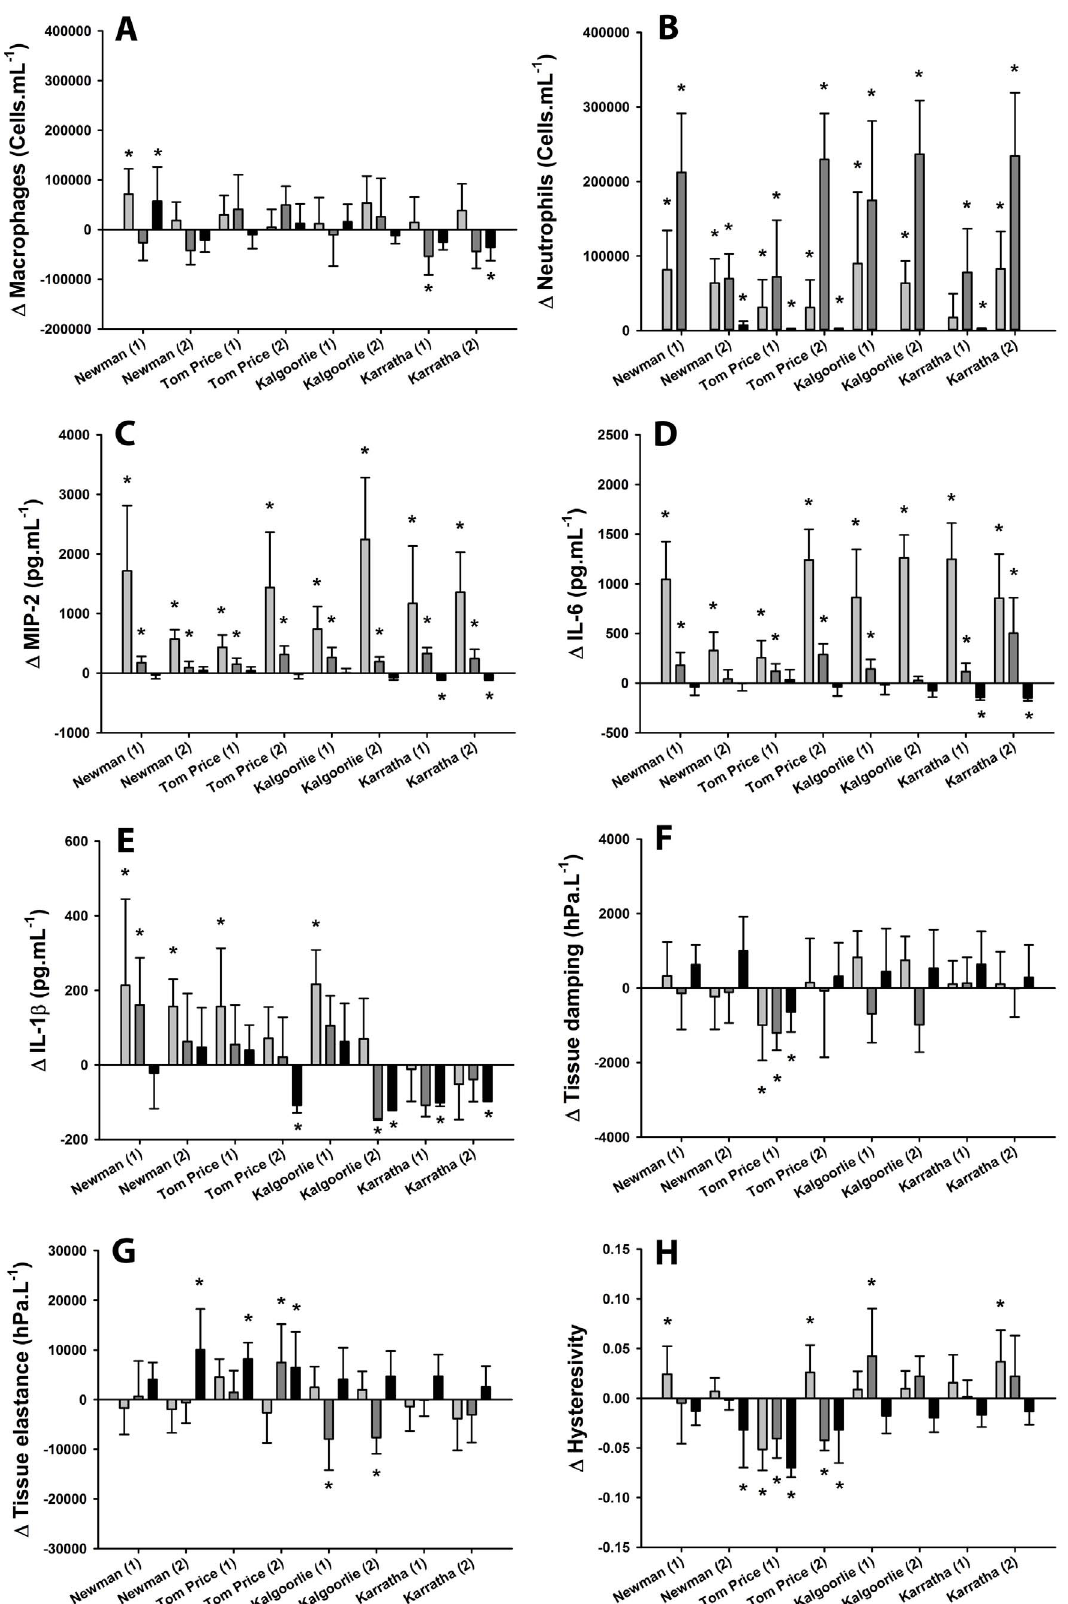
Figure 1. The inflammatory and lung function response to geogenic particles in mice varies depending on the origin of the particles. Levels of macrophages (A), neutrophils (B), MIP-2 (C), IL-6 (D), IL-1 b (E), tissue damping (F), tissue elastance (G) and hysteresivity (H) in mice